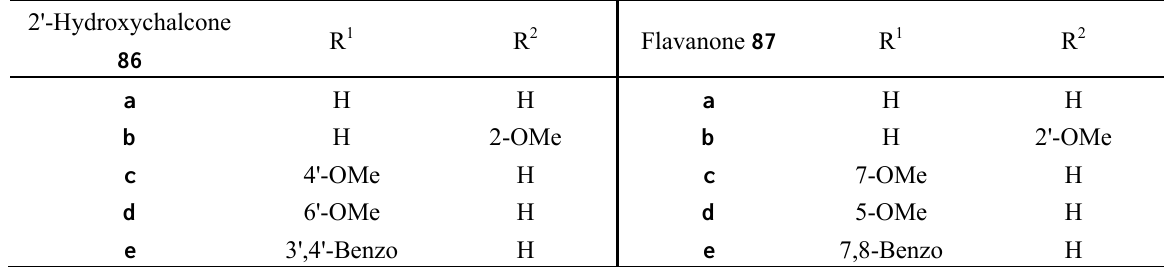
Table 6. Photocyclization of 2'-hydroxychalcones to flavanones.